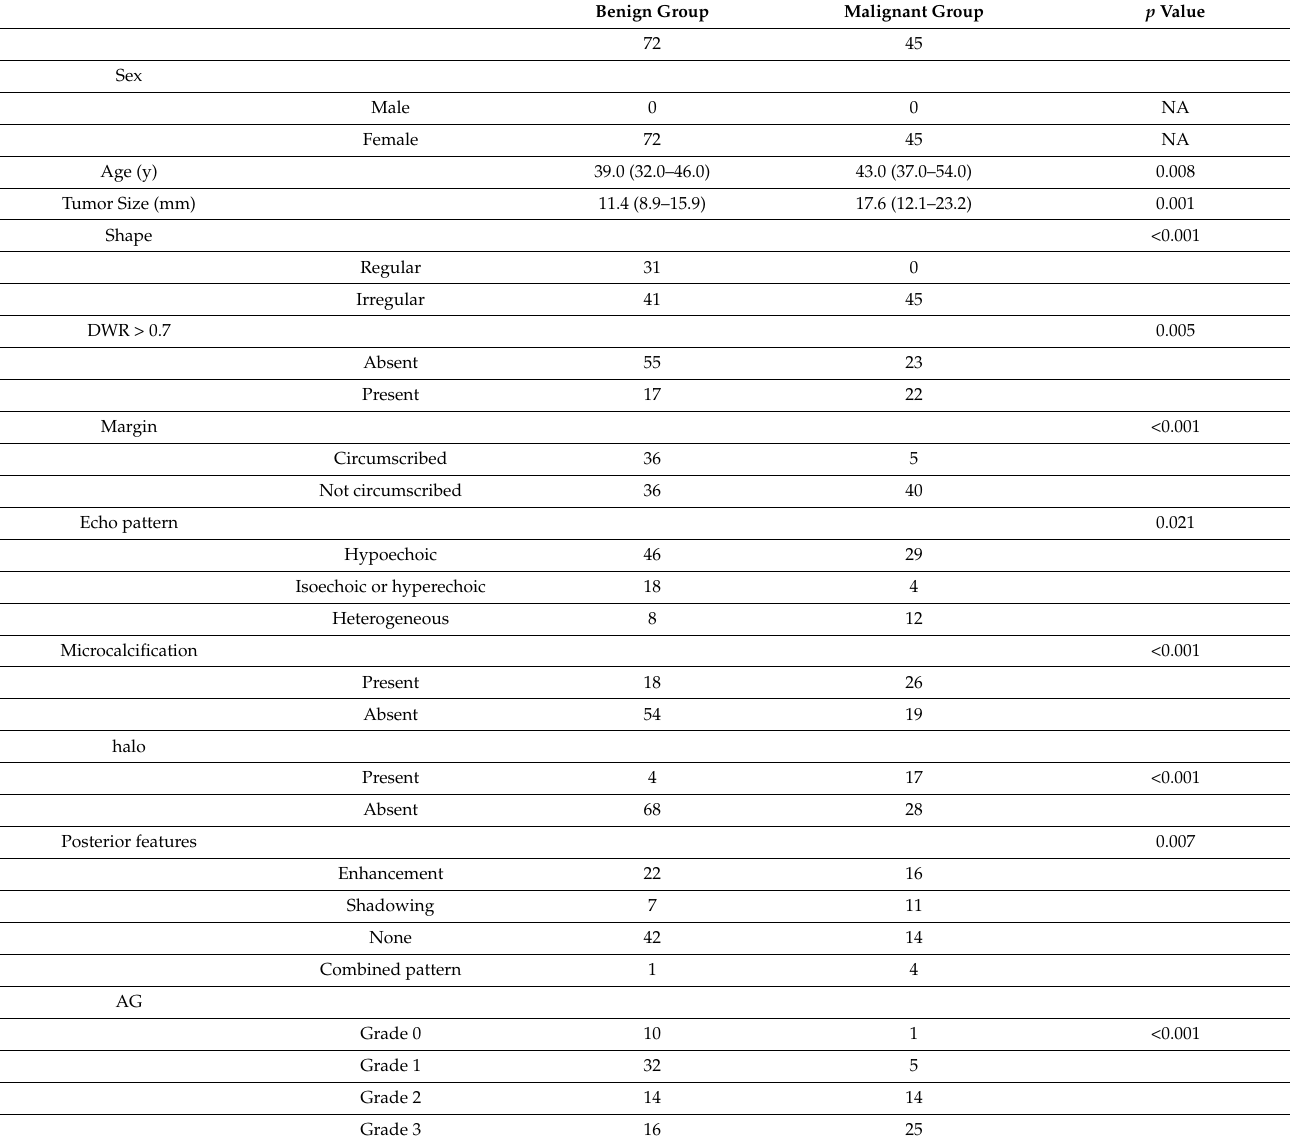
Table 1. Baseline characteristics of enrolled